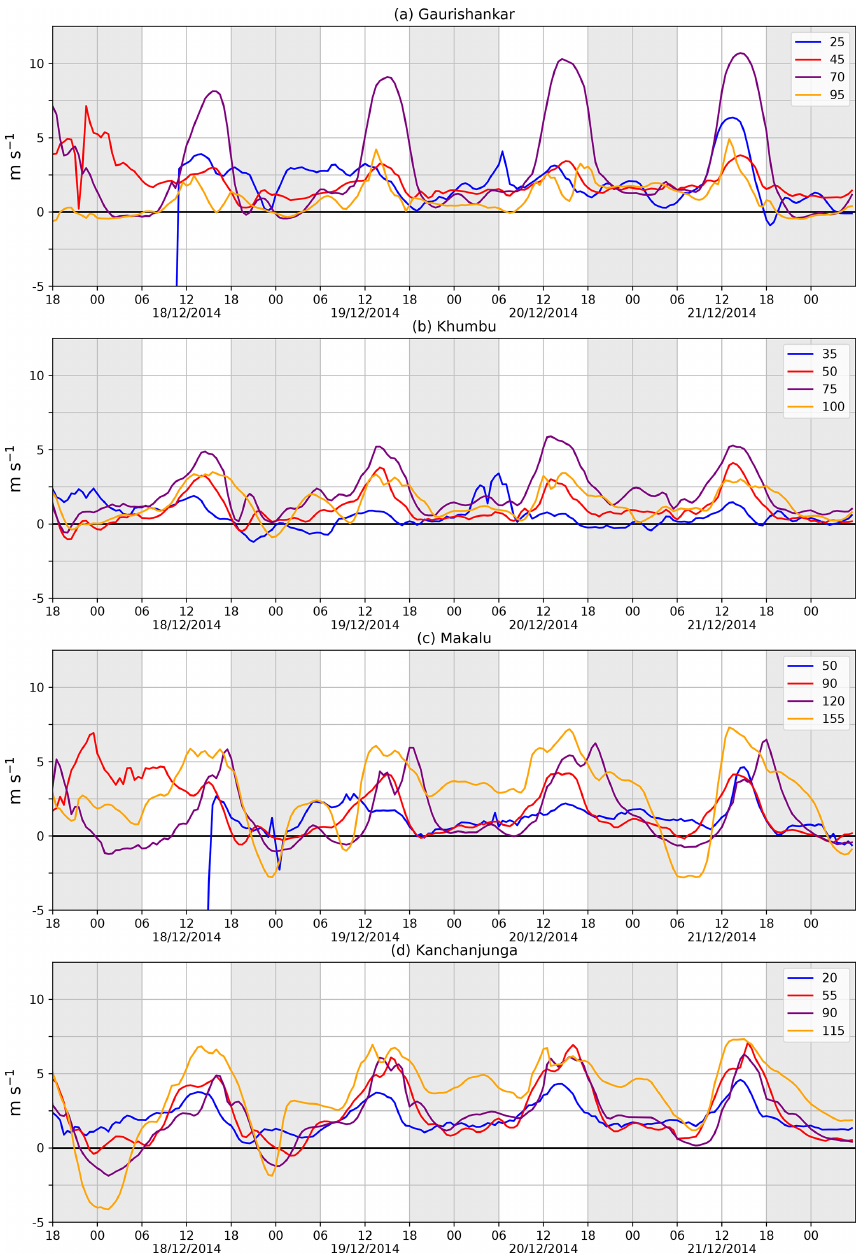
Figure 6. Along-valley wind velocity in different parts of each of the four valleys (crosses of the same colours in Figs. 2 and 3) on the fourth model level (approximately 300m above the surface). The numbers in the legends refer to the along-valley grid points as plotted on the x axes of Fig. 3. Positive values of wind velocity refer to up-valley winds. Local time is shown on the x axes. The data are plotted every 30min. The same analysis with an extended y scale to show the along-valley wind velocities less than − 5ms − 1 is shown in the Supplement (Fig.